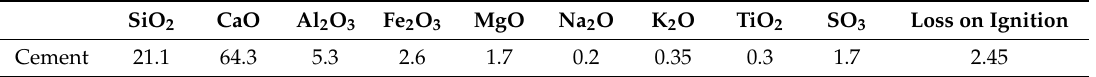
Table 1. Chemical compositions of cement (wt